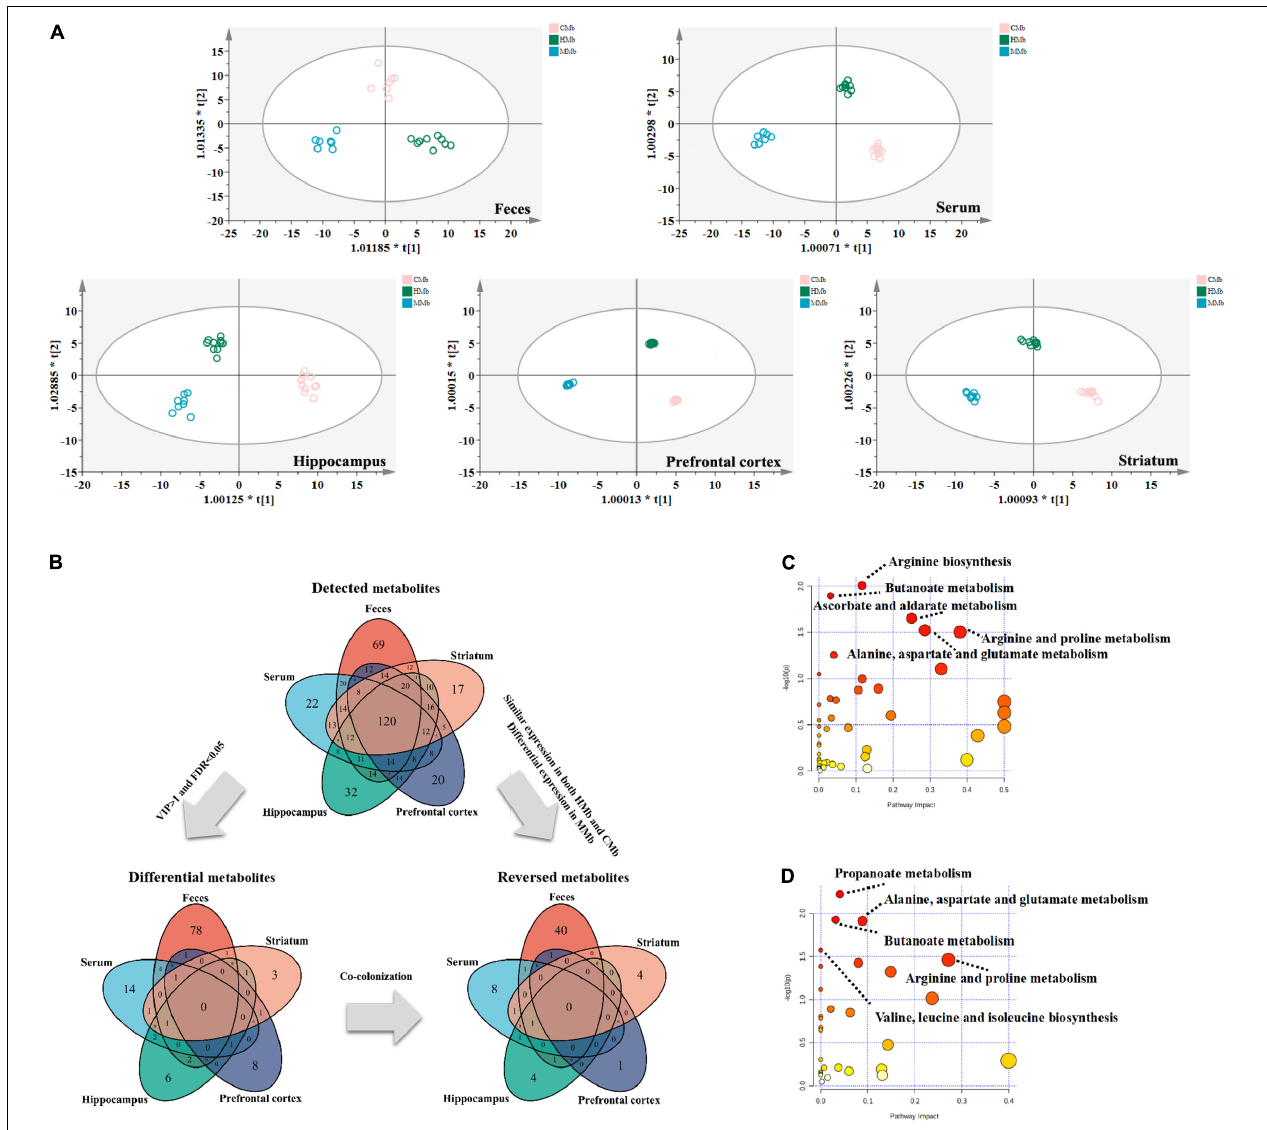
FIGURE 2 | Overview of reversed metabolites in the MGB axis of MG comorbid anxiety. (A) Orthogonal partial least square discriminant analysis (OPLS-DA) of metabolic status in feces (R2X[cum] = 0.353, R2Y[cum] = 0.944, Q2[cum] = 0.711), serum (R2X[cum] = 0.5, R2Y[cum] = 0.986, Q2[cum] = 0.842), hippocampus (R2X[cum] = 0.498, R2Y[cum] = 0.954, Q2[cum] = 0.643), prefrontal cortex (R2X[cum] = 0.74, R2Y[cum] = 0.999, Q2[cum] = 0.742) and striatum (R2X[cum] = 0.638, R2Y[cum] = 0.989, Q2[cum] = 0.778) in MGB axis showed clear discrimination among CMb, HMb, and MMb groups. (B) Total amount of detected metabolites, differential metabolites and reversed metabolites from feces, serum, hippocampus, prefrontal cortex and striatum found in HMb and MMb groups. (C) The metabolic pathways in which all differential metabolites were enriched. (D) The metabolic pathways in which all reversed metabolites were enriched. MGB axis, “microbiota-gut-brain”